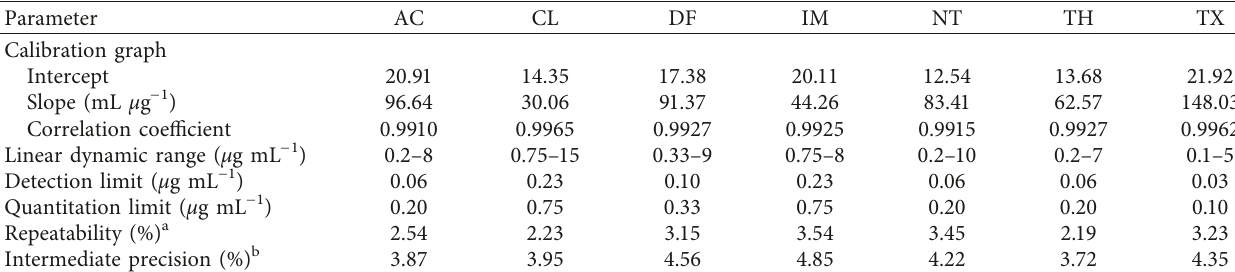
Table 1: Analytical parameters for all the studied analytes.